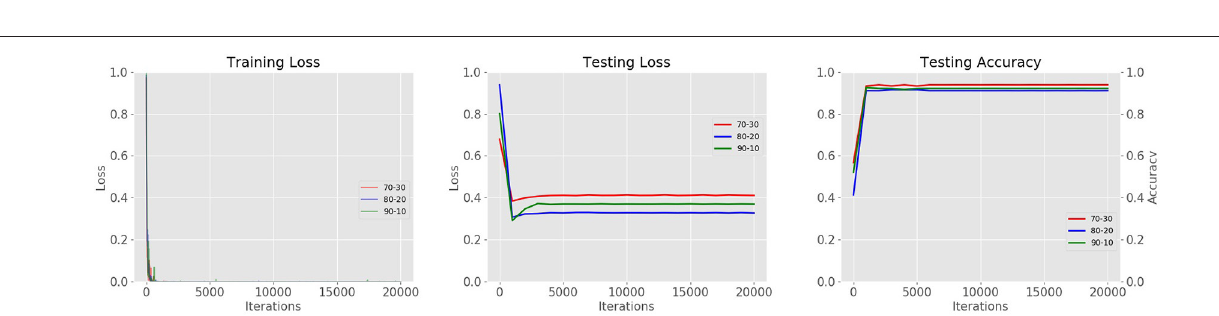
Frontiers in Plant Science |